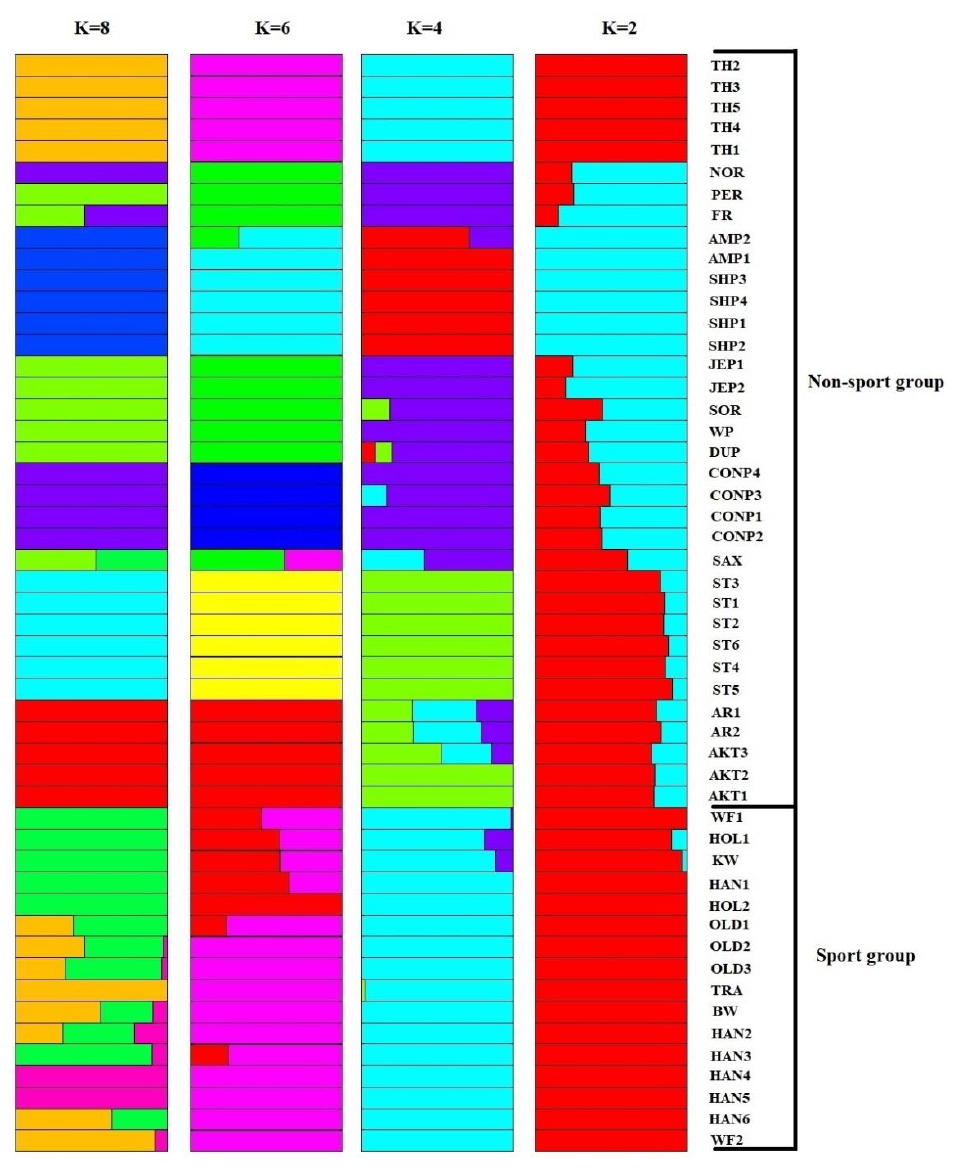
Figure 3. Bayesian clustering plot for 4 K values (K = 2, K = 4, K = 6, and K = 8) in 51 horses. Each horse is indicated horizontally which is divided into colored blocks and each color demonstrates one ancestral population. The sport breeds are Baden-Wurttemberg (BW), Dutch warmblood (KW), Hanoverian (HAN), Holstein (HOL), Oldenburg (OLD), Trakehner (TR), and Westphalian (WF). Non-sport breeds are Akhal-Teke (AKT), American Miniature (AMP), Arabian (AR), Connemara pony (CONP), Dülmen pony (DUP), Friesian (FR), Jeju pony (JEP), Noriker (NOR), Percheron (PER), Saxon-Thuringian Heavy Warmblood (SAX), Shetland pony (SHP), Sorraia (SOR), Standardbred (ST), Thoroughbred (TH), and Welsh pony (WP).